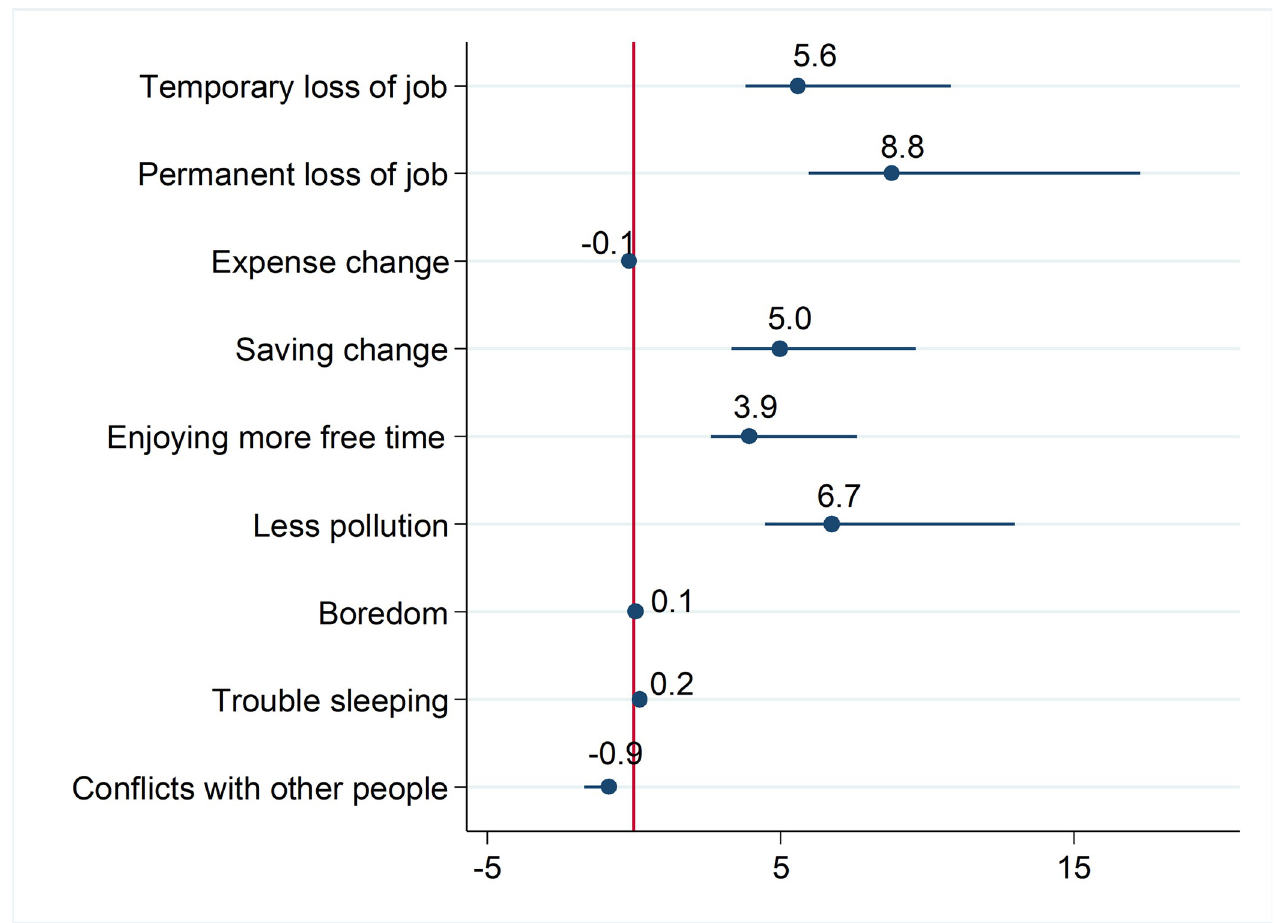
Fig 4. The proportion of the indirect impacts to the total impacts of being in the poorest quintile and overall assessment of government responses through several mediating variables (%) (point estimates and the 95% confidence interval). This figure presents the estimates of the indirect effects using “medeff” command in Stata